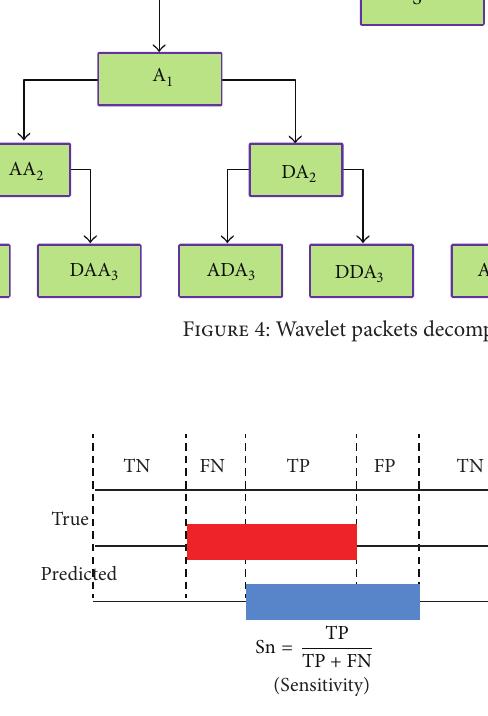
Figure 5: Measures of prediction accuracy at the nucleotide